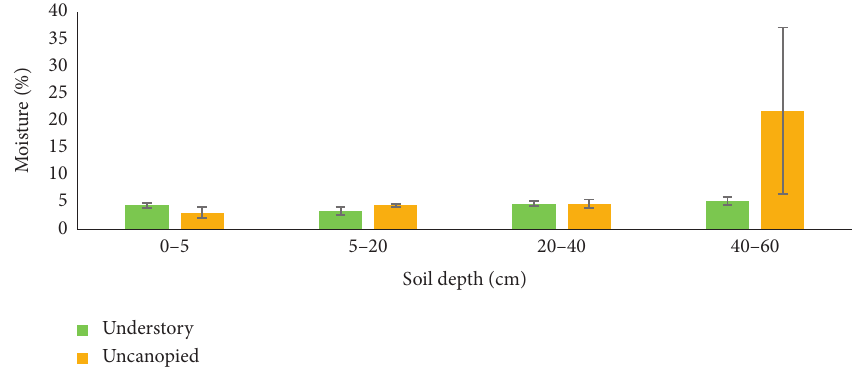
Figure 4: Soil moisture content in the understory of mesquite trees and the uncanopied adjacent